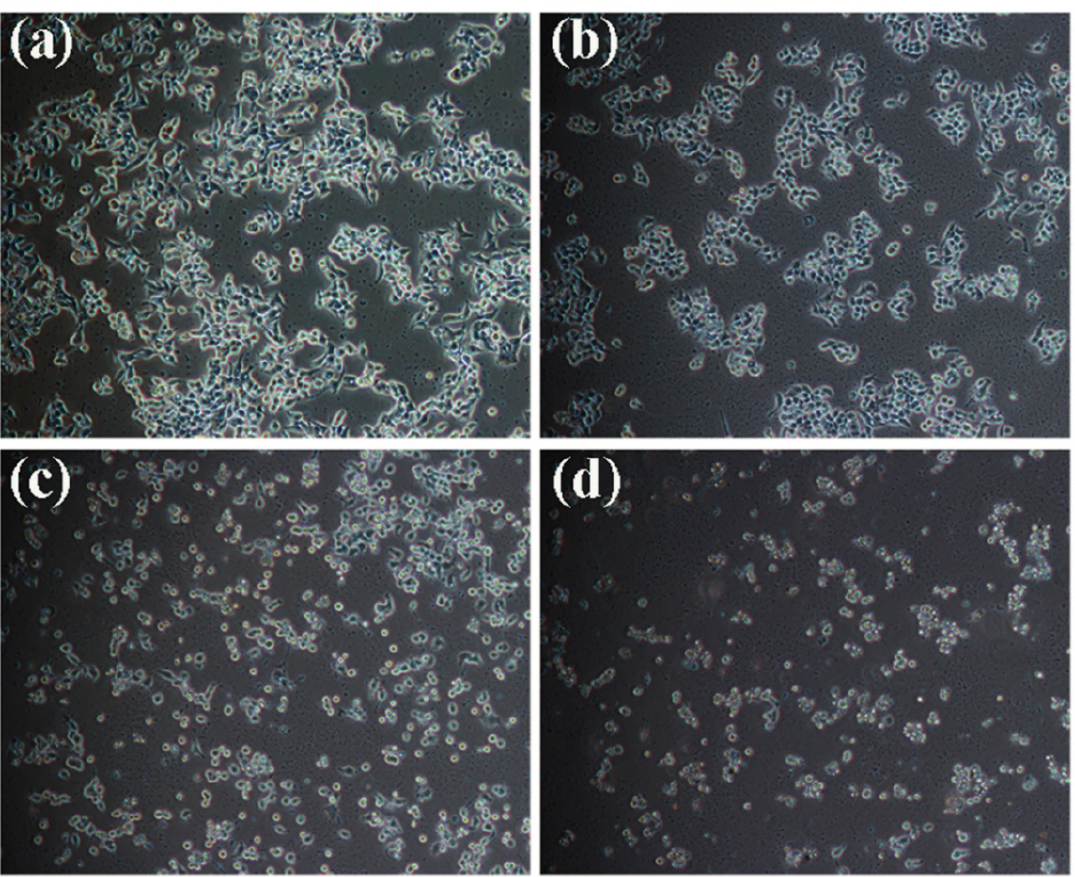
Figure 2. Kansenone-induced inhibitory cell proliferation in IEC-6 cells with different concentrations for 48 h, which was visualized using a microscope (magnification,